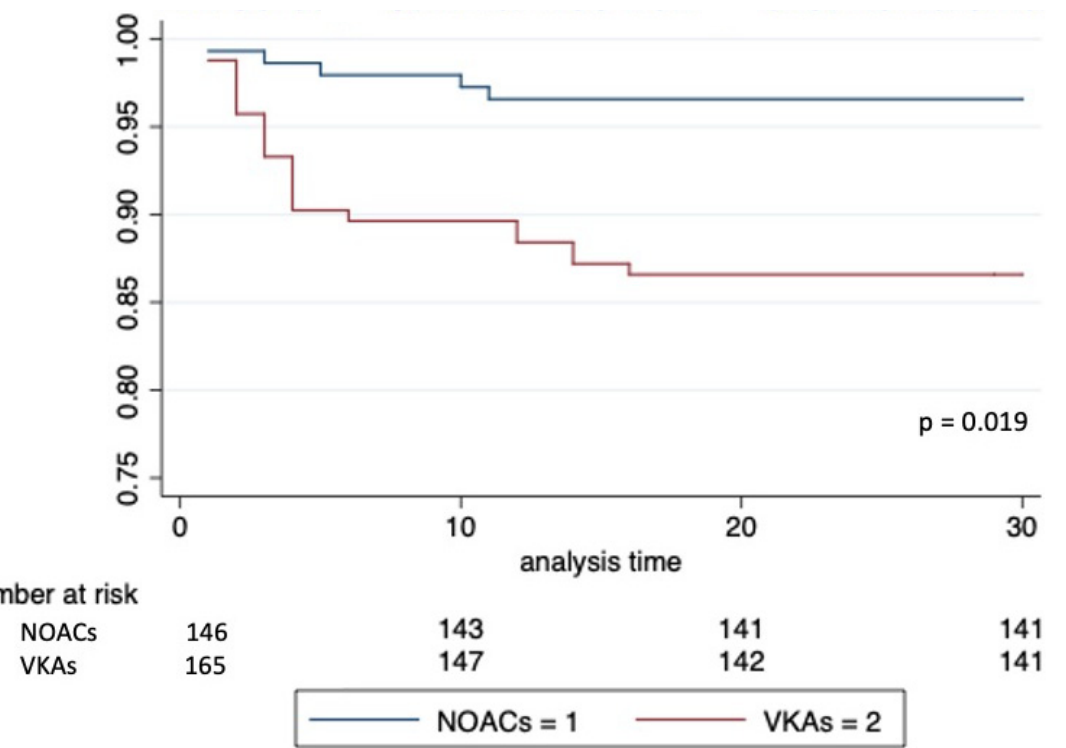
Figure 1. Kaplan–Meier curve for pocket hematoma-free survival at 30 days by different oral anticoagulation strategy (NOACs vs. VKAs). NOACs = Non-vitamin K antagonist anticoagulants; VKAs = Vitamin K antagonist anticoagulants.